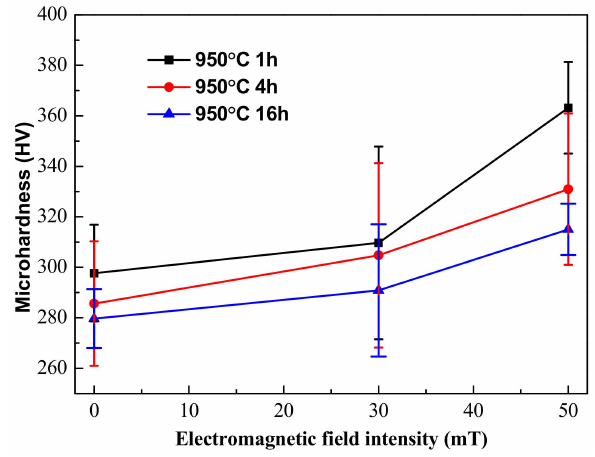
Figure 11. Microhardness of the δ phase in the EMS-LSFed Inconel 718 superalloy samples fabricated